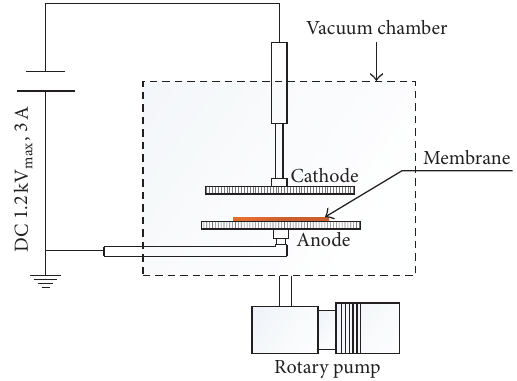
Figure 1: DC-plasma system and components.